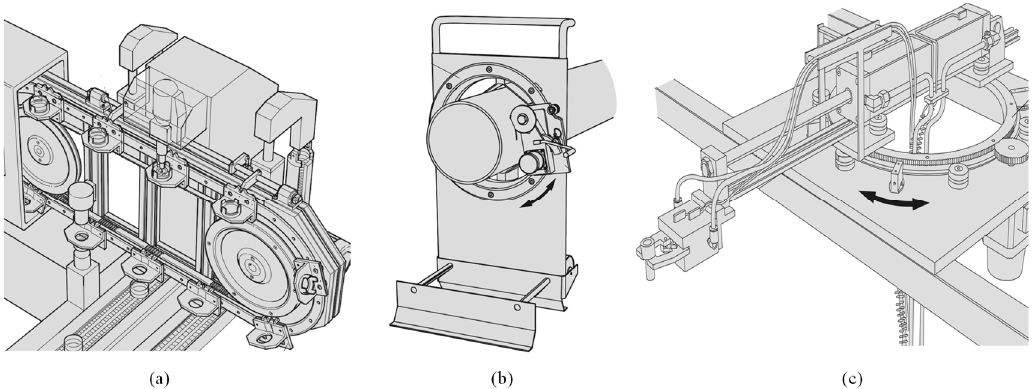
Figure 2. Application of circular and linear slide: ( a ) Optical lens assembly machine, ( b ) moving saw for tube cutting, ( c ) pick and place robot.